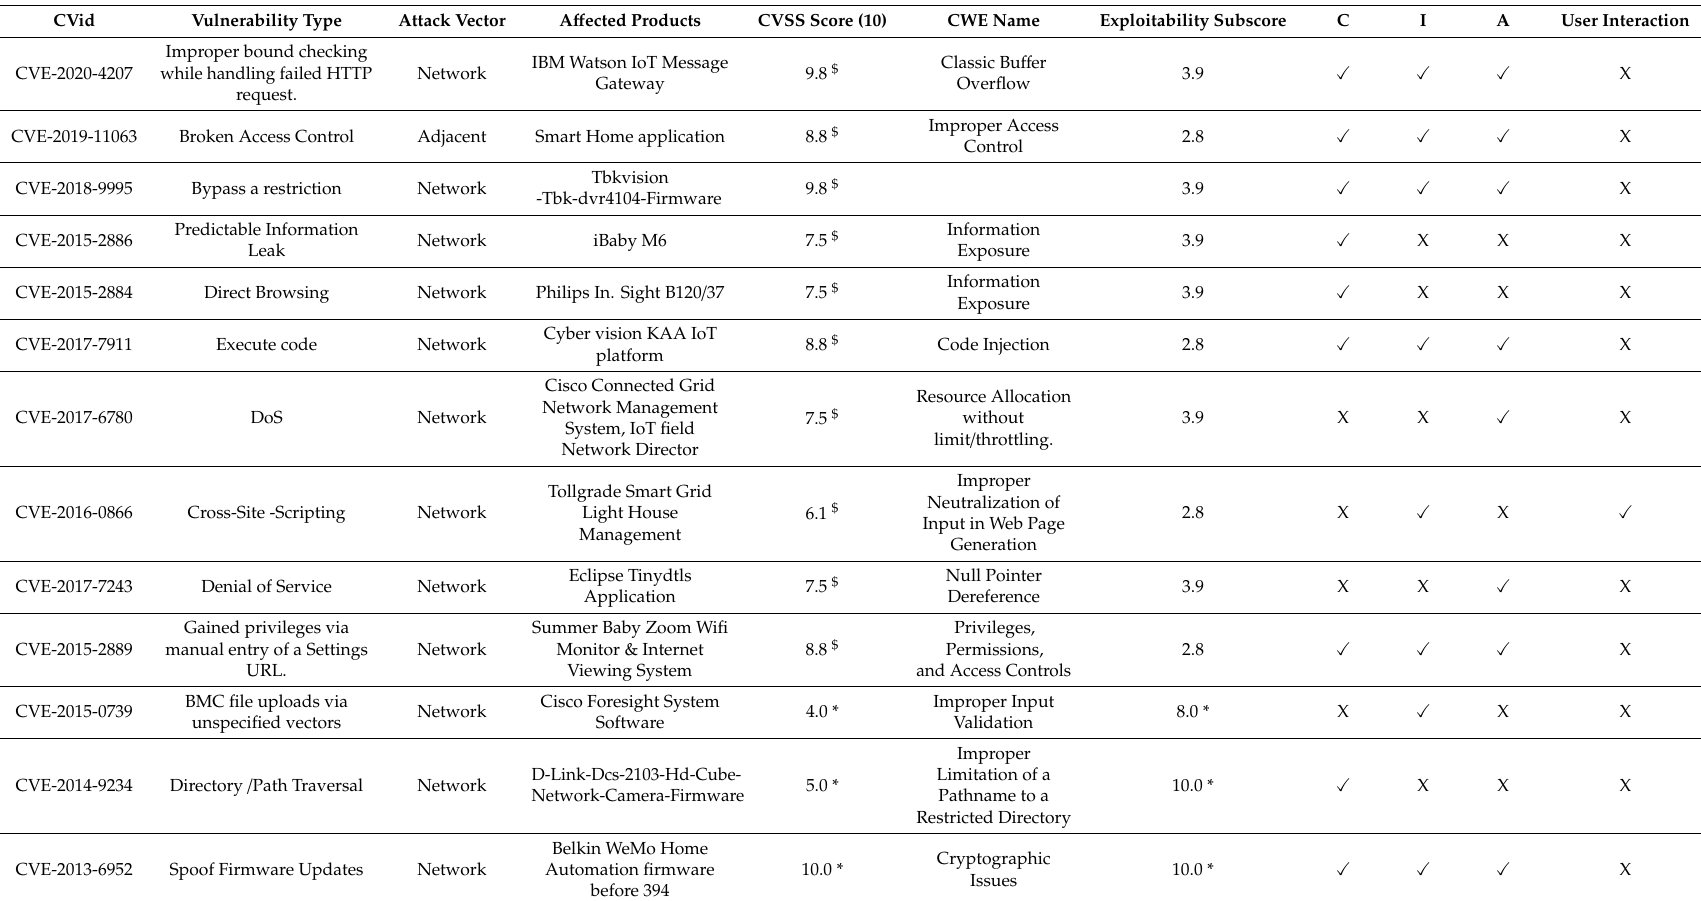
Table 3. IoT Vulnerabilities and their